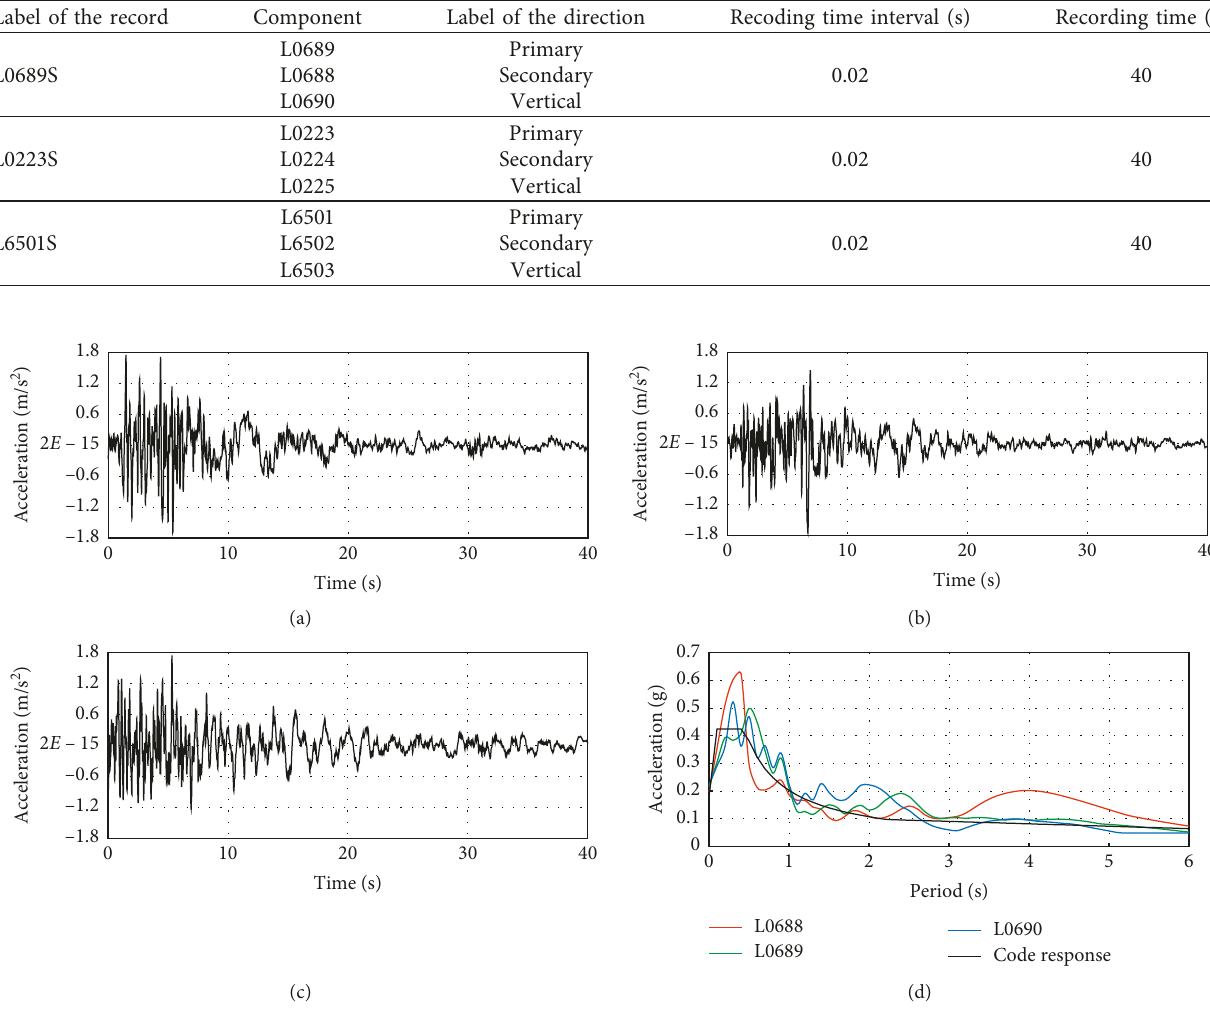
Table 2: Parameters of the earthquake records.